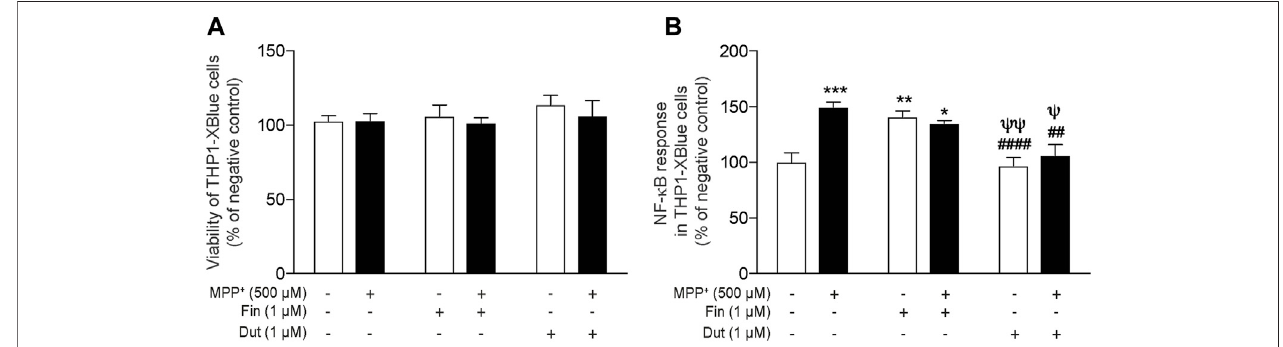
FIGURE 5 | Dutasteride but not fi nasteride treatment inhibited the induction of NF- κ B proin fl ammatory response by MPP + in a human monocytic cell line. NF- κ B activity was determined in the supernatant of monocytic cells treated with fi nasteride (Fin) or dutasteride (Dut) combined or not with the MPP + toxin. Using THP1-XBlue cells containing NF- κ B reporter gene allowed the evaluation of NF- κ B activation level in this human cell line. Histogram show (A) THP1-XBlue cell viability quanti fi cation (MTTassay)and (B) NF- κ Bresponseaspercentageofnegativecontrol.Resultsarethemeanofthreeexperiments.* p < 0.05,** p < 0.01,*** p < 0.001comparedto control; ## p < 0.01 and #### p < 0.0001 compared to MPP + treatment; ψ p < 0.05 and ψψ p < 0.01 compared to fi nasteride